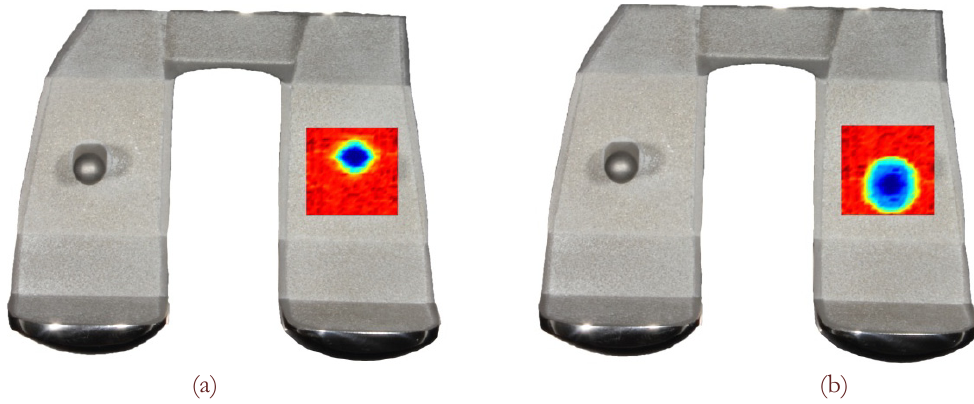
Figura 15: Posizione relativa dell’area di contatto per il carico di 900 N (a) e di 2700 N (b). Figure 15: Relative position of the contact area for 900 N (a) and 2700 N